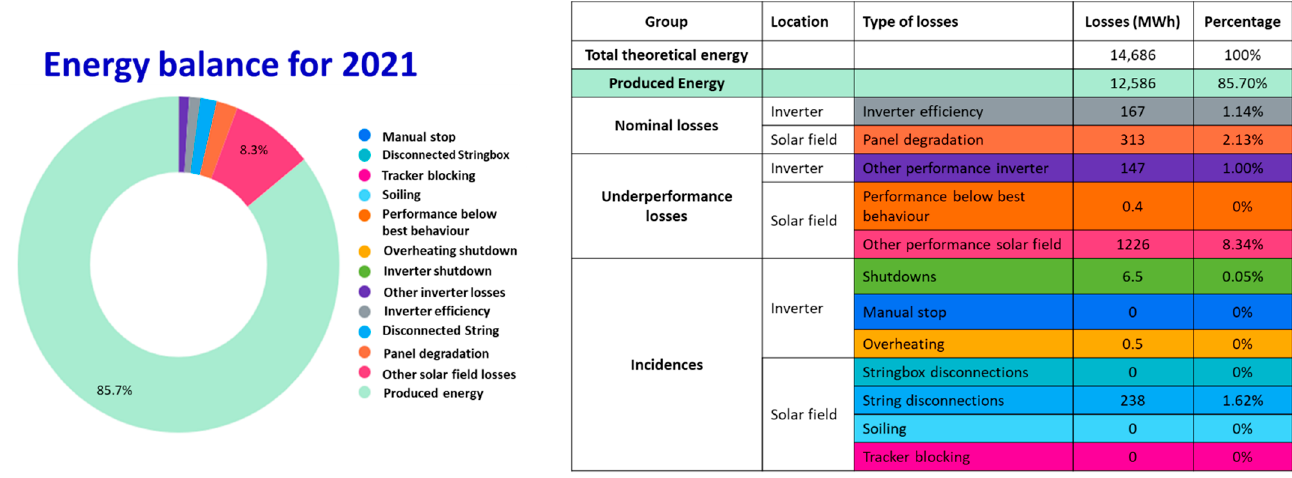
Figure 20. Energy loss breakdown (given by different colors) for the test PV plant over the evaluation period (January to December 2021).